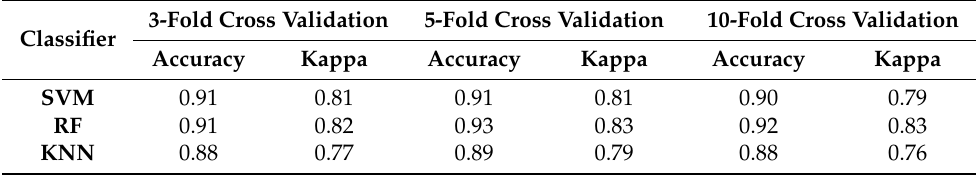
Table 6. Summary of classification methods with 3-, 5-, 10-fold cross validation (train